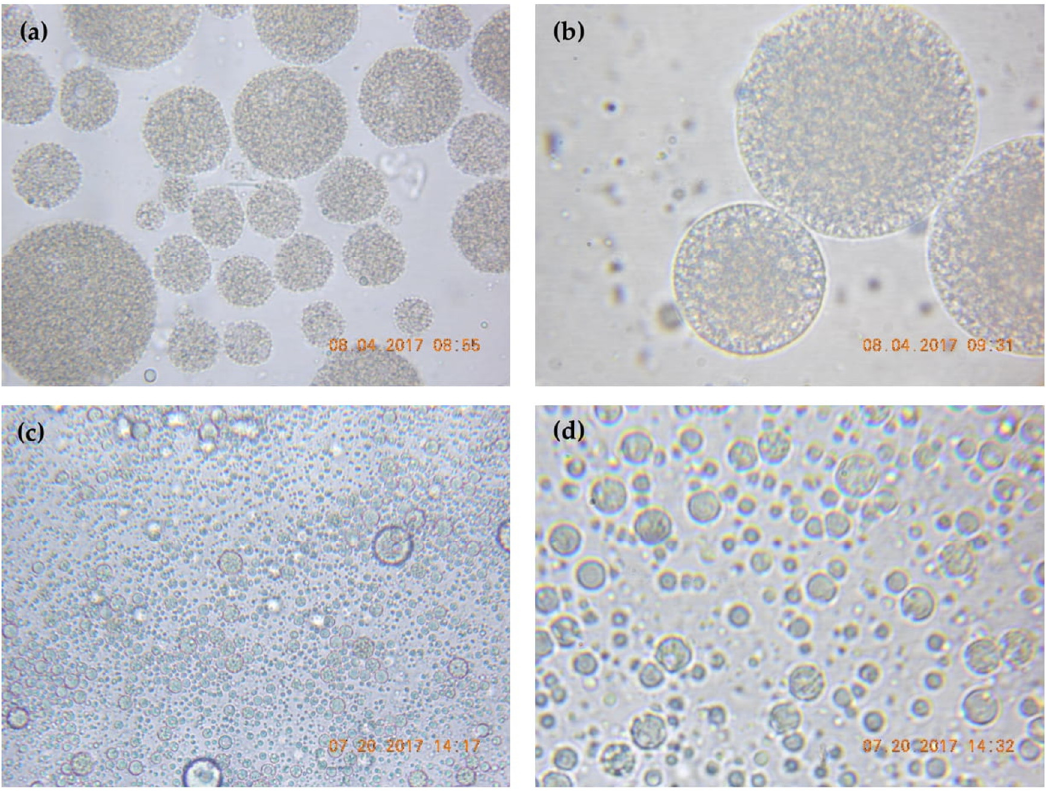
Figure 4. Images of W/O/W emulsion before SP: ( a ) 400× and ( b ) 1000× and reconstituted W/O/W emulsion: ( c ) 400× and ( d ) 1000×. Drying conditions for W/O/W emulsion: 160–80 °C.